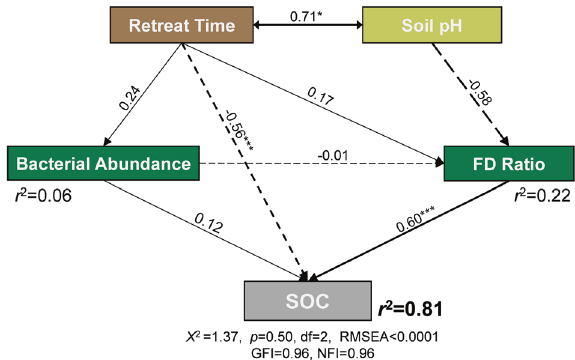
Fig. 5 Structural equation modeling of the impacts of environ- mental factors and bacterial community on soil organic carbon (SOC) along the Laohugou Glacier No. 12 foreland. SOC and FD ratio denote soil organic carbon and gene abundance ratio between carbon fi xation and carbon degradation. Numbers adjacent to arrows are standardized path coef fi cients. Arrow width is propor- tional to the strength of the path coef fi cients. Signi fi cance levels of each path are * p < 0.05, ** p < 0.01, and *** p < 0.001. Dashed and solid lines indicate the negative and positive effects, respectively. The r 2 values positioned next to each r esponse variable in the model denote the proportion of variance (Fig. 5). Bacterial abundance had direct positive effects on SOC content because the growth of bacteria improves the accumula- tion of microbial necromass in soil [57]. From the perspective of microbial functions, the FD ratio had a stronger direct effect on the SOC content. A lower FD ratio indicates the lower ef fi ciency of carbon fi xation and higher consumption of carbon during the 50- year recession, consistent with the change of SOC. This can explain the reduction of SOC because microbial carbon fi xation